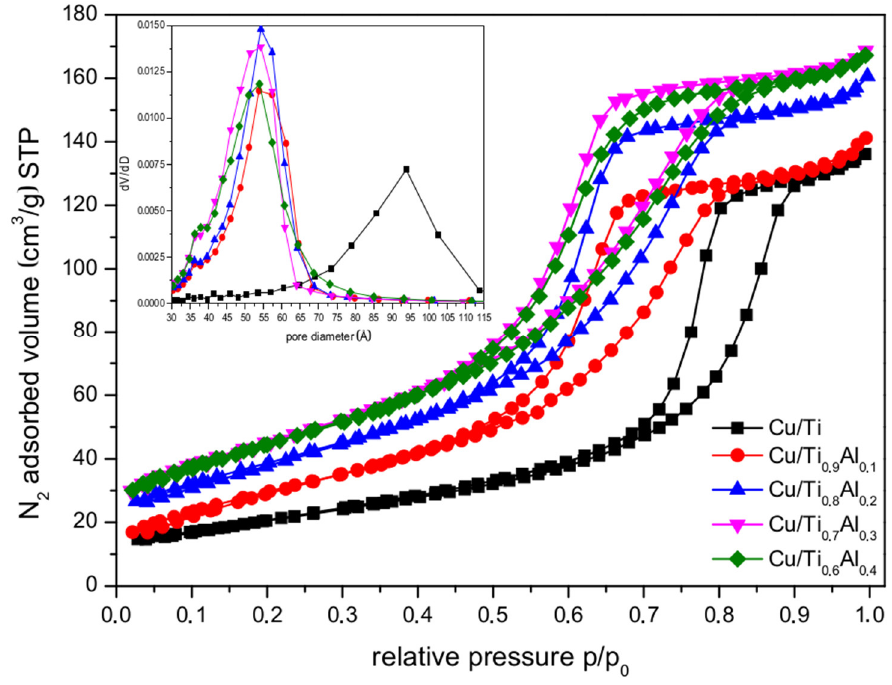
Figure 4. Nitrogen sorption isotherms and BJH pore distribution (inset) of Cu/Ti x Al 1-x catalysts. Table 2. Surface elemental composition of fresh and used catalysts